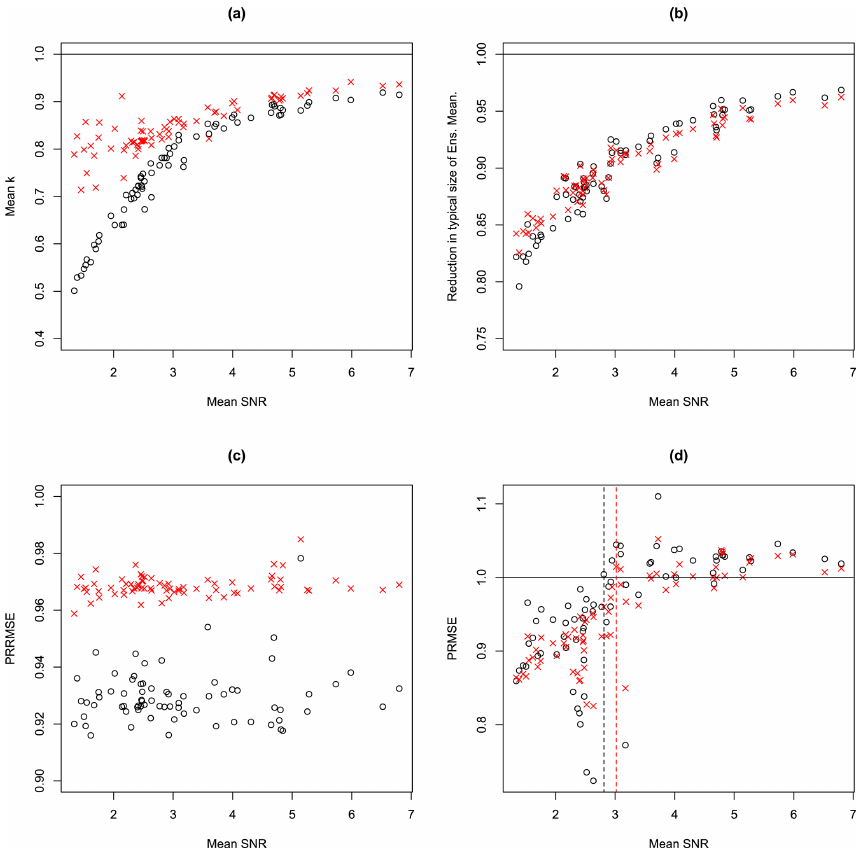
Figure 9. Various diagnostics for each of the 72 EURO-CORDEX climate change projections, plotted versus mean SNR. Results from applying the SPMA scheme are shown with black circles, and results from applying the BPMA scheme are shown with red Xs. Panel (a) shows mean values of the parameters ˆ k S and ˆ k B , panel (b) shows the reduction in the typical size of the ensemble mean (calculated as described in the text), panel (c) shows the reduction in the relative PRMSE (the PRRMSE), and panel (d) shows the PRMSE ratio. Panel (d ) has additional vertical lines showing the cross-over points, below which the PMA results are all better than the ensemble mean